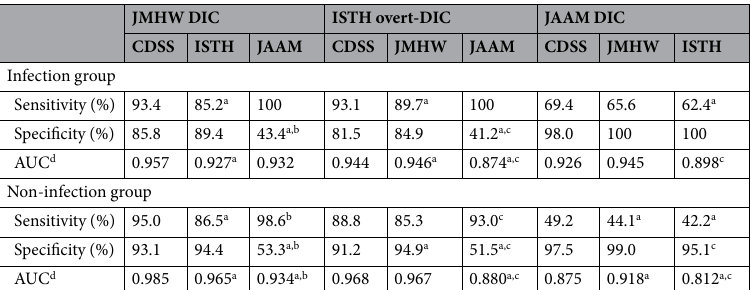
Table 3. Receiver operating characteristic (ROC) analyses for the relative standard CDSS, Chinese DIC Scoring System; JMHW, Japanese Ministry of Health and Welfare; ISTH, International Society on Thrombosis and Haemostasis; JAAM, Japanese Association for Acute Medicine; AUC, area under the ROC curve. a p < 0.05 vs. CDSS; b p < 0.05 vs. ISTH; c p < 0.05 vs. JMHW; d p < 0.001 for each